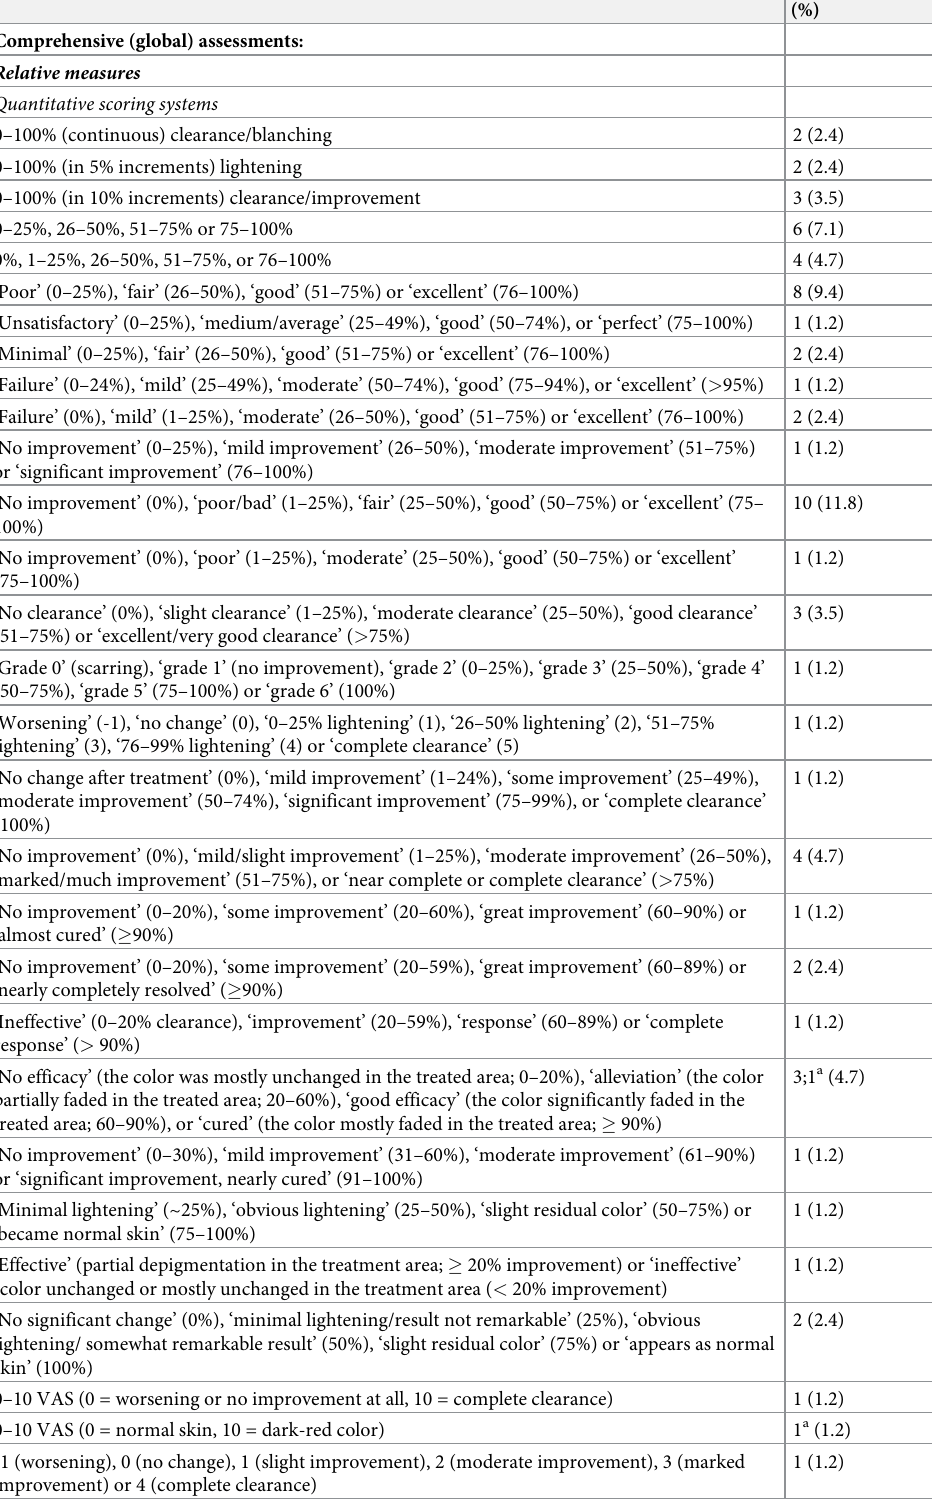
Table 1. Measures and scoring systems used for observer/clinician-reported efficacy assessments in prospective PWS trials from 2005 to May